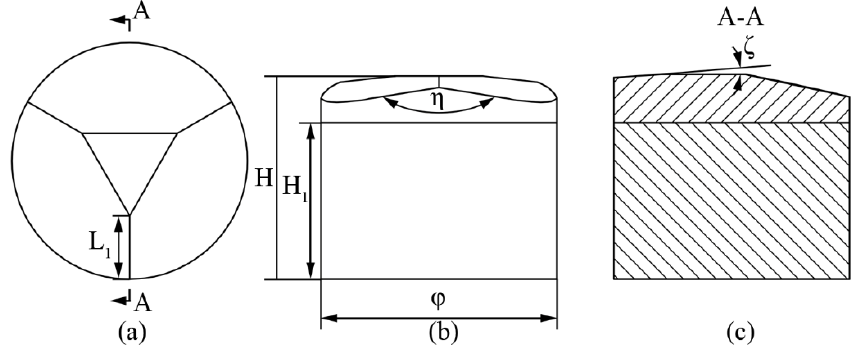
Figure 3. Structure parameters of 3-RDE non-planar cutter: (a) Top view; (b) Main view; (c) Section view.